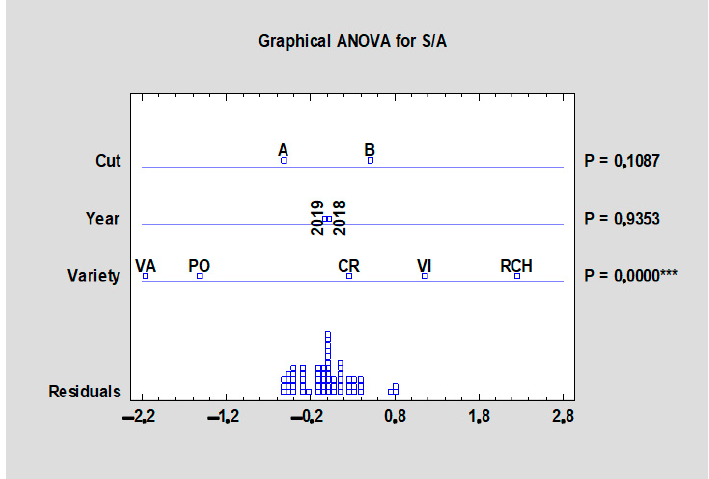
Figure 11. Effect of the experimental year, cultivar, and term of the harvest on the sugar/acid ratio in the rhubarb cultivars. Abbreviations: PON, ‘Poncho’; CRE, ‘Canadian Red’; VAL, ‘Valentine’; RCH, ‘Red Champagne’; VIC, ‘Victoria’. LSD test with significance: p ≤ 0.001 (***). The pH of rhubarb juice varied between 2.77 (‘Poncho’, THA) and 3.25 (‘Canadian Red’, HTB), as shown in Table 10, which corresponded with Welbaum [2], where the pH of rhubarb juice was measured to be 3.2; therefore, large quantities of sugar are often used to prepare rhubarb dishes. The cultivar had a significant influence ( p < 0.001) on pH, as shown in Figure 12, while the year and term of harvest did not have a significant